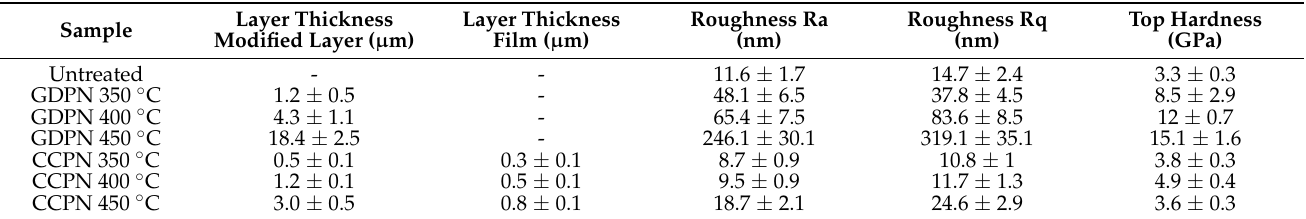
Table 1. The thickness of modified layers and films, roughness, and hardness of the untreated and nitrided samples.